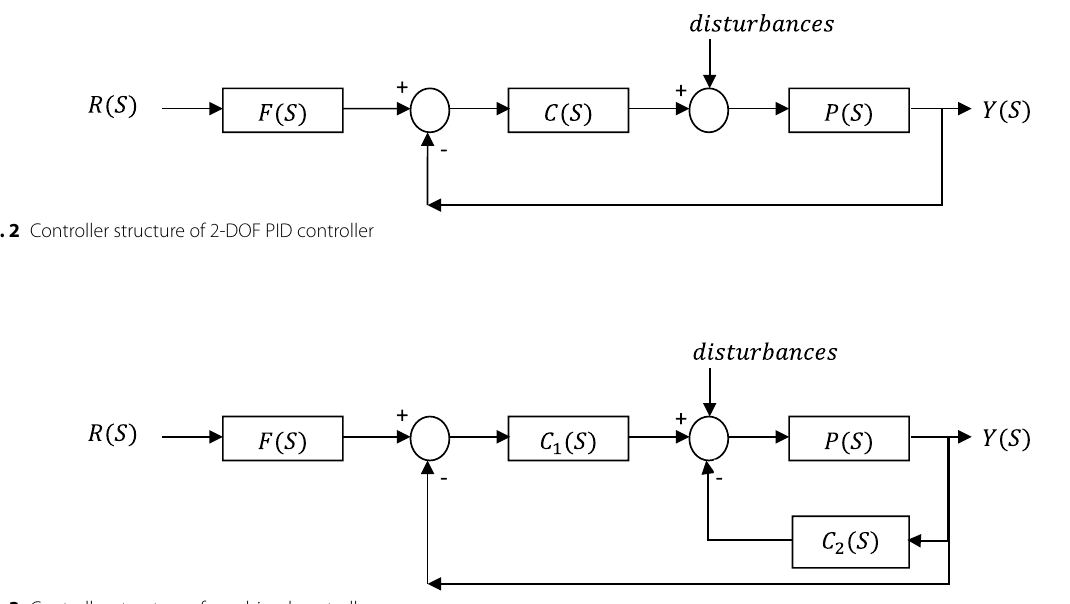
Fig. 3 Controller structure of combined